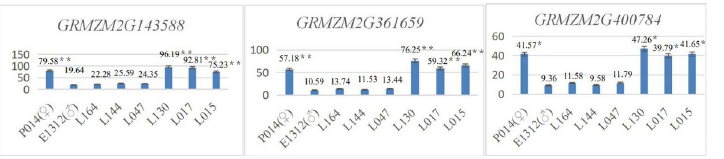
Fig 11. GRMZM2G143588 , GRMZM2G361659 and GRMZM2G400784 qRT-PCR expression levels in the biparental mapping